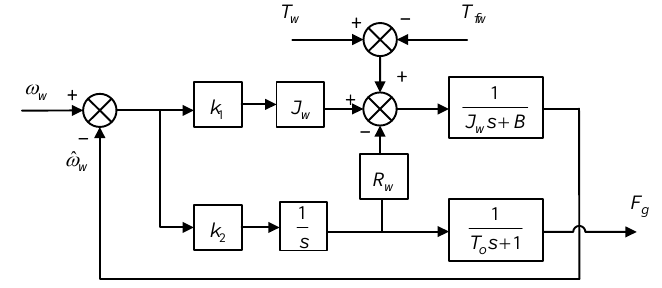
Figure 3. Diagram of the tension observer principle block.